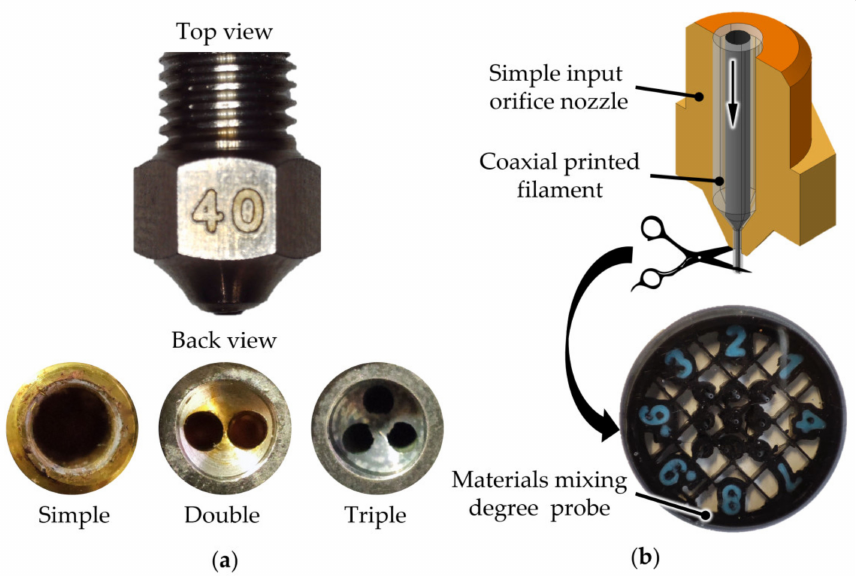
Figure 1. Considered nozzles in the experimental runs. ( a ) Nozzles’ input geometry. ( b ) The method used to take samples of the extruded